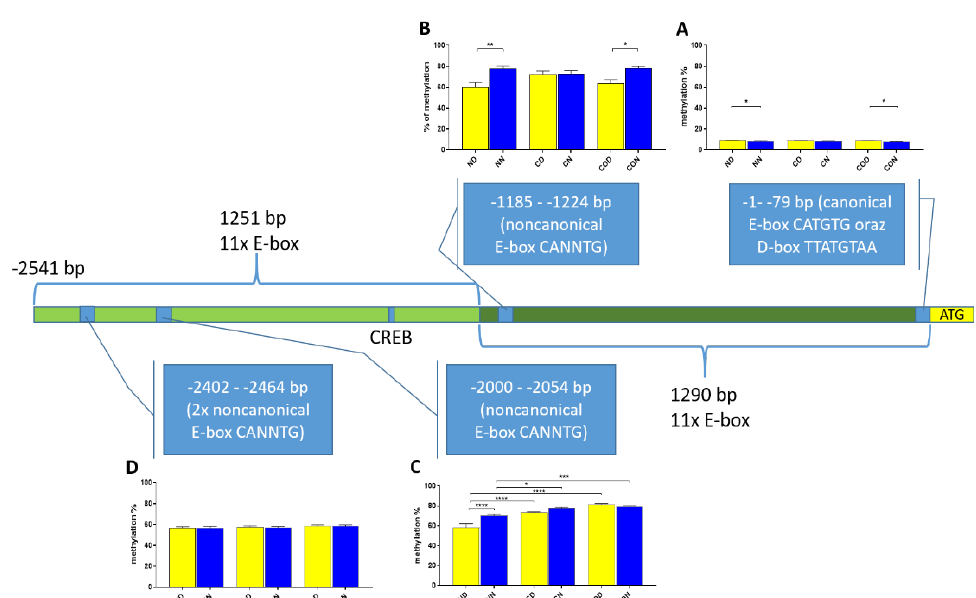
Figure 6. Scheme of promoter sequence −2500 bp downstream ATG with changes in daily total methylation level of the examined sites, −1–−79 bp ( A ), −1185–−1224 bp ( B ), −2000–−2054 bp ( C ), −2402–−2464 bp, ( D ) in the normal (N), control (C) and CO-treated groups. The differences in total methylation level were compared in each group between day (yellow bar) and night (blue bar). The bars are represented as mean ± SEM. The asterisks indicate significant differences as follows: *— p < 0.05; **— p < 0.01; ***— p < 0.001; ****— p < 0.0001.